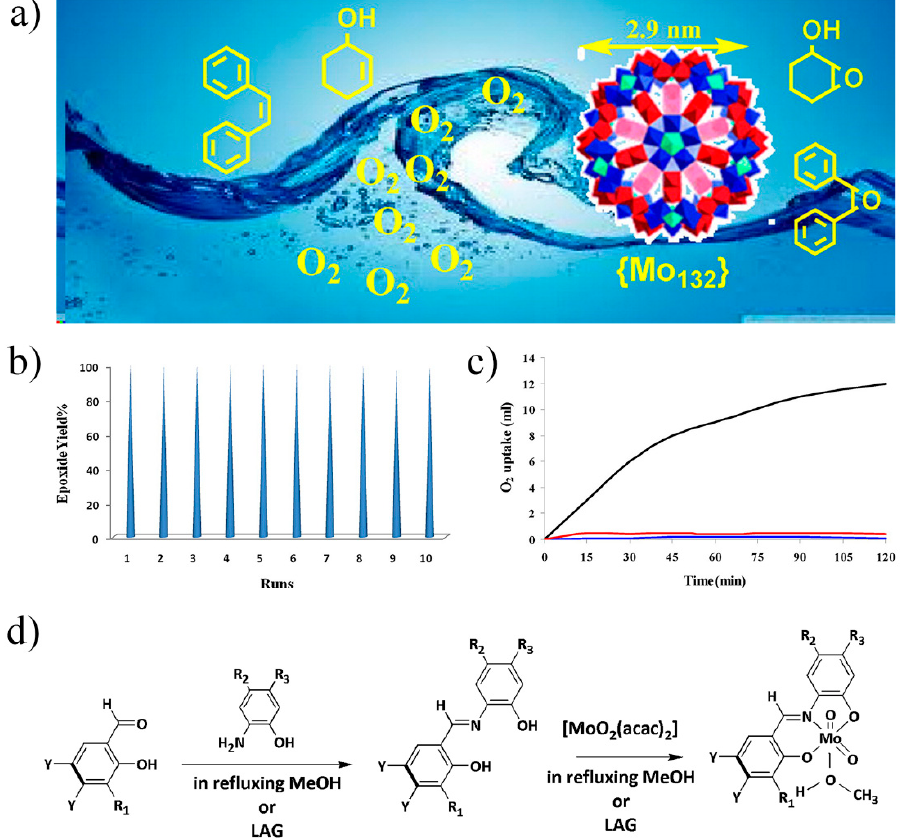
Figure 7. ( a ) Epoxidation of alkenes in water with {Mo 132 } nanoball; ( b ) time course of oxygen uptake by cyclooctene in the presence of {Mo 132 } (black line), (NH 4 ) 6 Mo 7 O 24 ·6H 2 O (blue line), and NaMoO 4 ·2H 2 O (red line) in water; ( c ) recycling of the catalytic system for aerobic epoxidation of cyclooctene in water. Reproduced with permission from reference [104]. ACS Publications (2013). ( d ) Two synthetic strategies of molybdenum (VI) complexes and ligands in epoxidation catalysts. Reproduced with permission from reference [105]. The Royal Society of Chemistry (2017). ( e ) Immobilization of the [MoO(O 2 ) 2 (phox)] complex on Cl/SBA-15 mesoporous silica. Reproduced with permission from reference [106]. Elsevier (2017). 4.3. Mechanism In the 1970s, two general mechanisms of Mo-based catalyzed epoxidation of olefins were proposed by Mimoun (Figure 8a) and Sharpless’s groups (Figure 8b). Mimoun [107] put forward a multi-step mechanism, where alkene was inserted into the metal-peroxo bond and then it was coordinated with the metal center. A five-membered metallacycle was assumed to act as an intermediate. Sharpless [17,18] proposed a mechanism which did not include a direct interaction